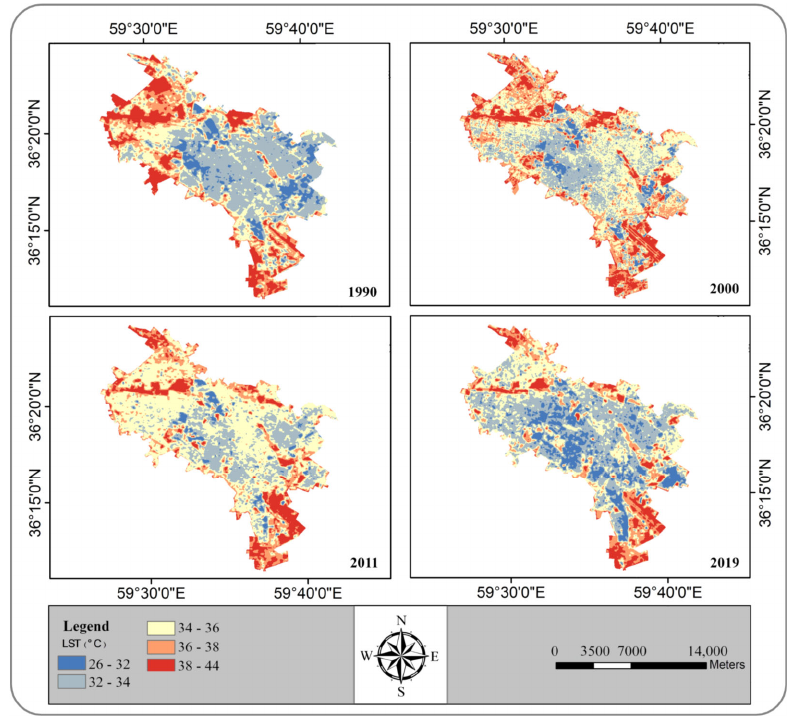
Figure 6. LST maps of Mashhad city for 1990 ( top left ), 2000 ( top right ), 2011 ( bottom left ), and 2019 ( bottom right ).